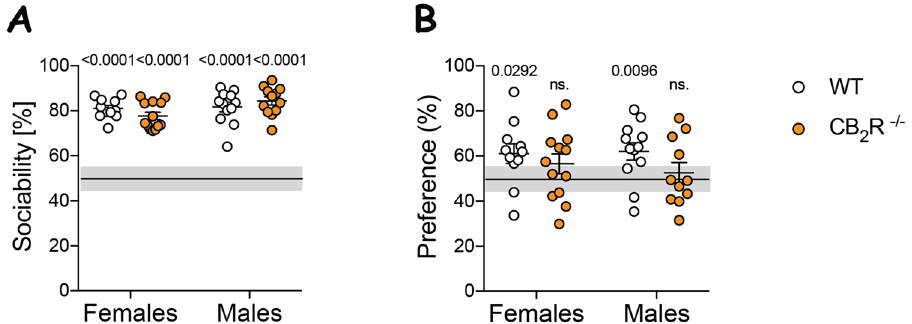
Figure 5. CB 2 R deletion decreases social memory in both male and female mice. ( A ) Sociability (%) was calculated as interaction time with a partner mouse over total interaction time. A mean value above 50% indicates that the mice are social. ( B ) Preference (%) for the novel partner was calculated as time with the novel partner mouse over total interaction time. Significant difference from the chance level (50%) indicates learning. White circle—WT; orange circle—CB 2 R −/− mice. Squares represent data from individual mice (N = 11–13 mice/ sex/genotype). Data are displayed as mean value ± SEM. Each group was analyzed individually by one-sample t-test (hypothetical mean = 50). The exact p-values are indicated on the